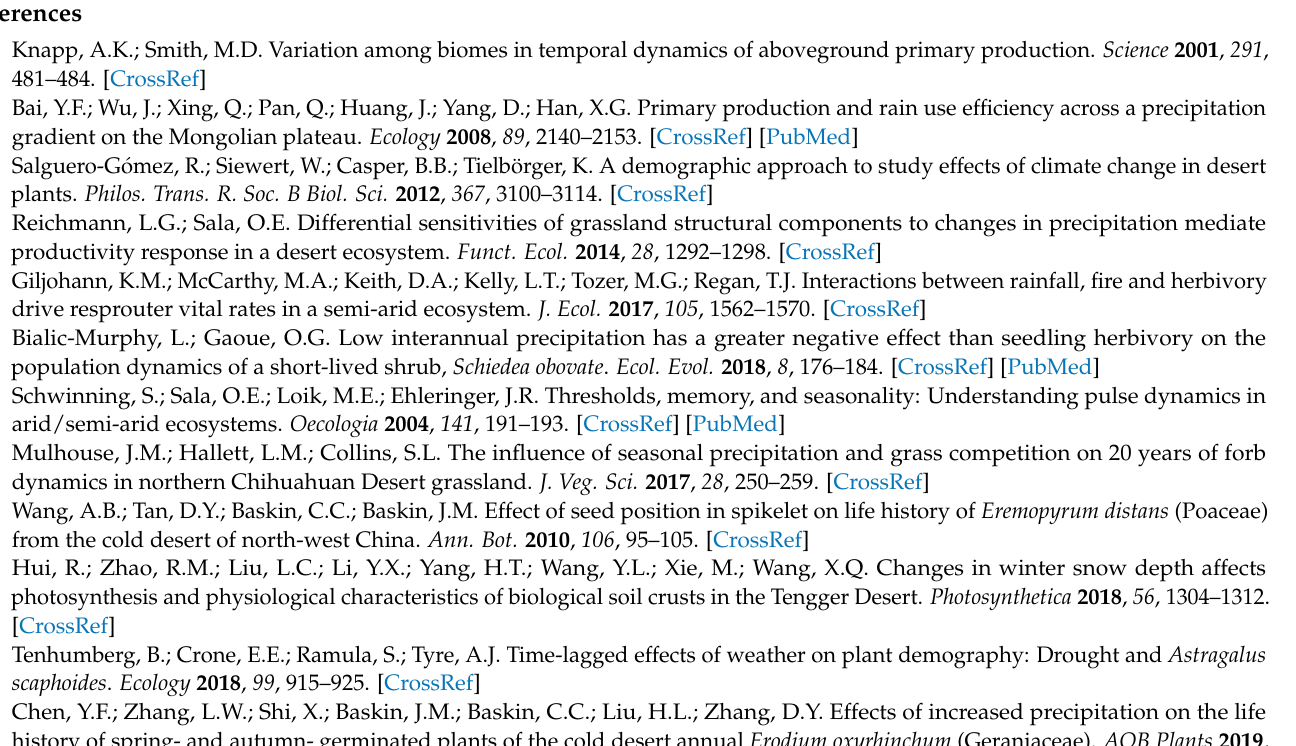
Table S3: Pearson correlations among life history traits of spring germinating plants (SG) of Erodium oxyrhinchum in dry springs; Table S4:Pearson correlations among life history traits of autumn germi- nating plants (AG) of Erodium oxyrhinchum in dry